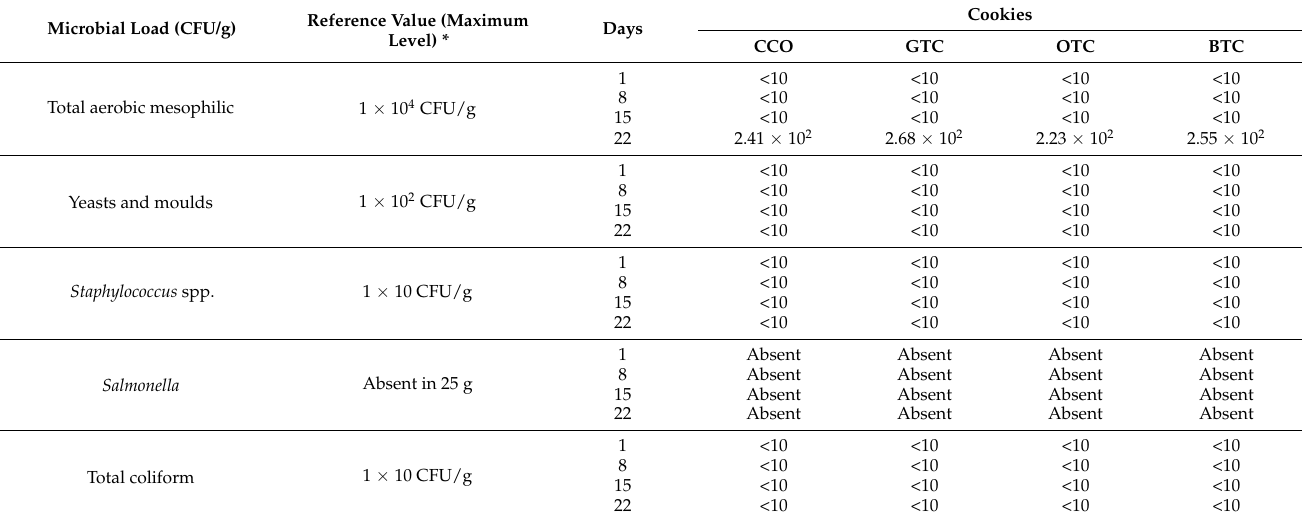
Table 8. The microbiological quality of non-gluten shortbread cookies with various spent tea leaf powders during different storage periods (day 1, 8, 15, and 22) at 25 ◦